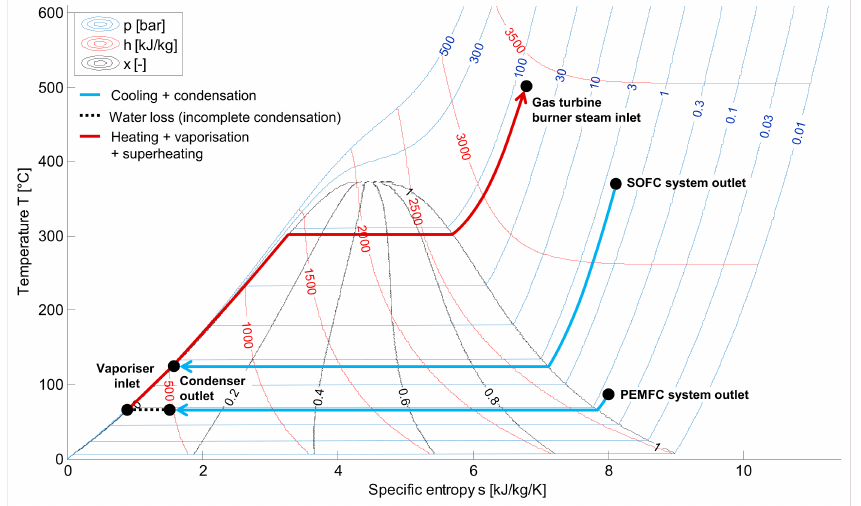
Figure 5. Temperature-entropy diagram for water with annotation of the water treatment processes for typical PEMFC and SOFC